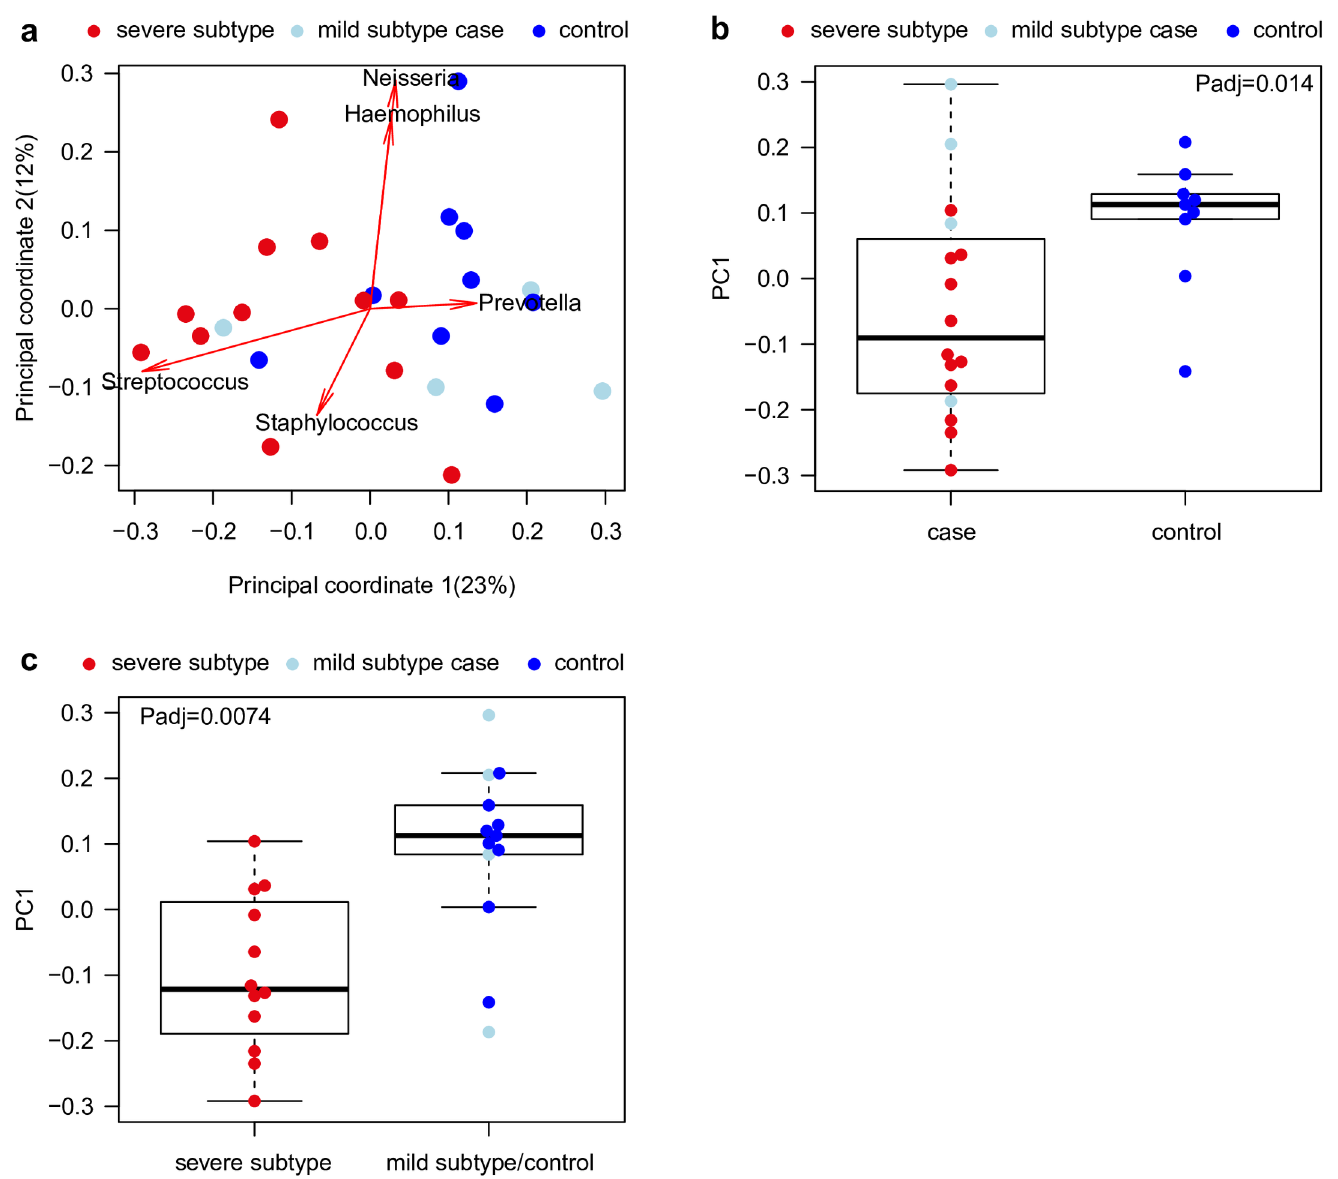
Fig 1. Genus level community composition for COPD patients with and without abnormalities in CT and controls based on PCoA. ( a ) Lung derived microbialcommunity compositionin severe subtype COPD patients, mild subtype cases and controls were comparedbasedon principal coordinate1 and 2. ( b ) Boxplot comparing principalcoordinate1 betweencase and control samples. ( c ) Boxplot comparing principalcoordinate1 for severe subtypeand mild subtype COPD patients and control samples. P-values were computed based on two-sidedWilcoxon-Mann-Whitney tests after correction for confounding effects from samples processedduringwinter or summer,